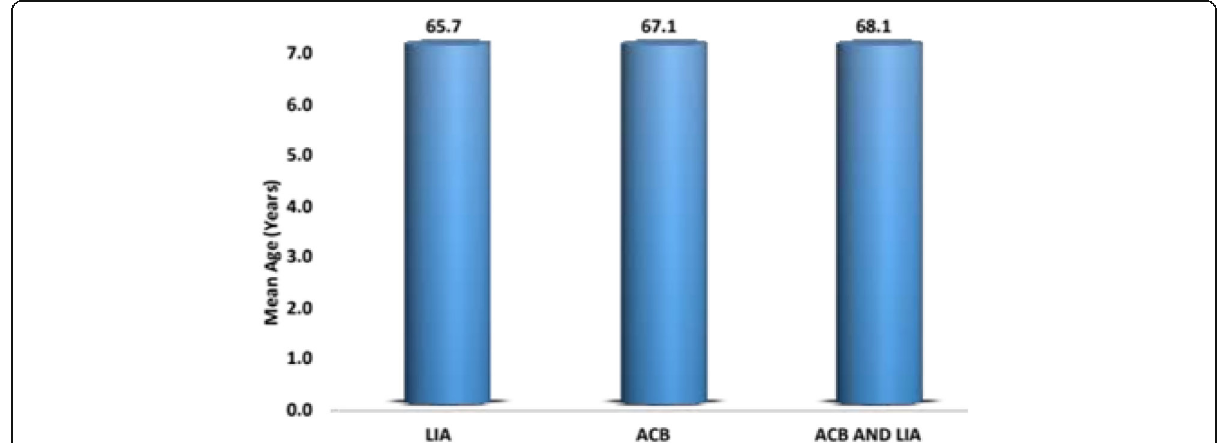
Fig. 3 Diagram showing mean age in all groups